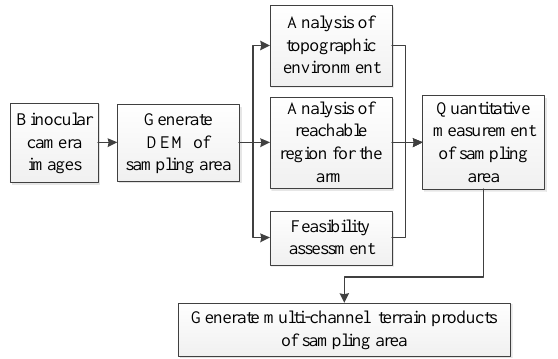
Figure 2. Sampling area feasibility analysis flow